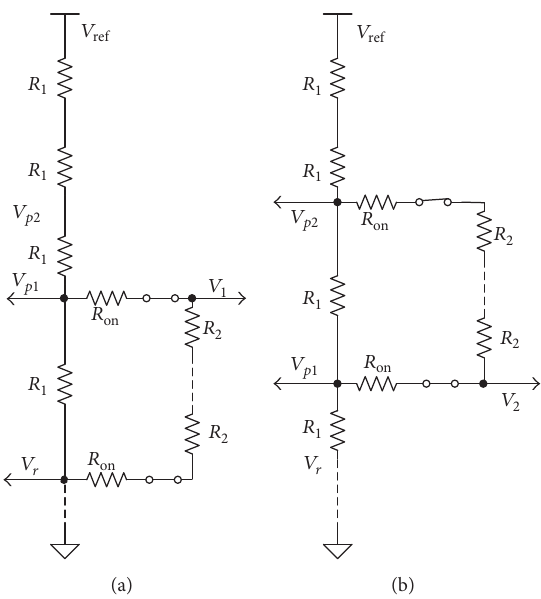
Figure 7: The schematic diagram of switching.